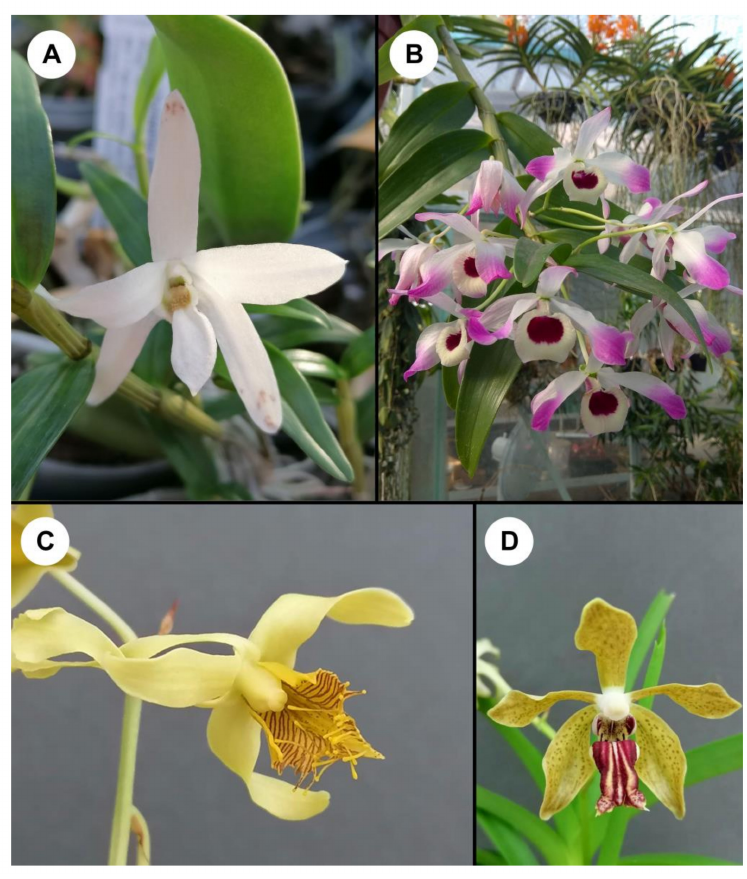
Figure 1. Some orchids with bioactive, antitumor compounds. ( A )— Dendrobium moniliforme , ( B )— Dendrobium nobile , ( C )— Dendrobium venustum , ( D )— Vanda